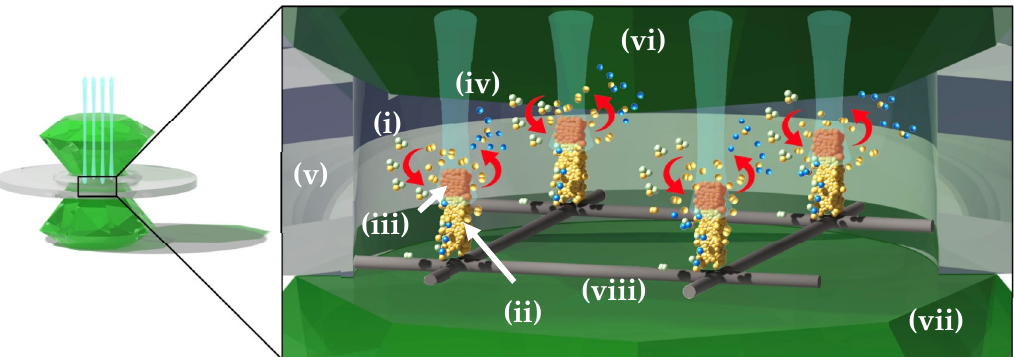
Figure 1. Illustration of the LRS-DAC method: (i) chemical precursor(s) (reactants) that transport to the reaction zone, (ii) the resulting product, (iii) the reaction zone where the incident laser interacts with the precursor(s), and (iv) byproducts of the reaction that may diffuse or segregate away from the product. Additional components include the (v) gasket chamber, (vi) pressure medium, and (vii) diamond anvils.